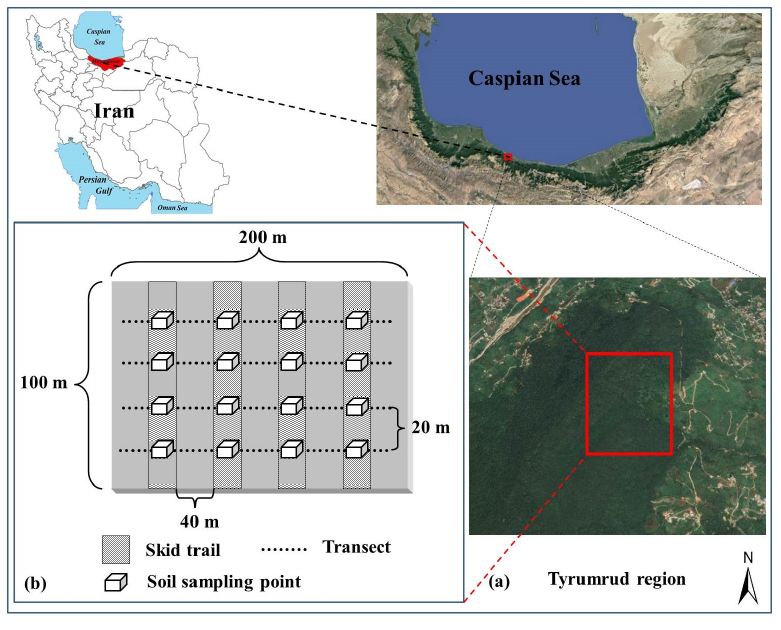
Figure 1. Location of the study area in the Hyrcanian forest, Northern Iran ( a ). A schematic diagram of the experimental design on the skid trails in each treatment of tree species ( b ). Table 1. The treatment characteristics (mean ± std) in the study area.